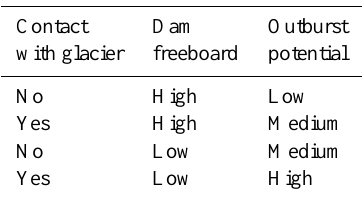
Table 3. The qualitative probability of an outburst defined by O’Connor et al.